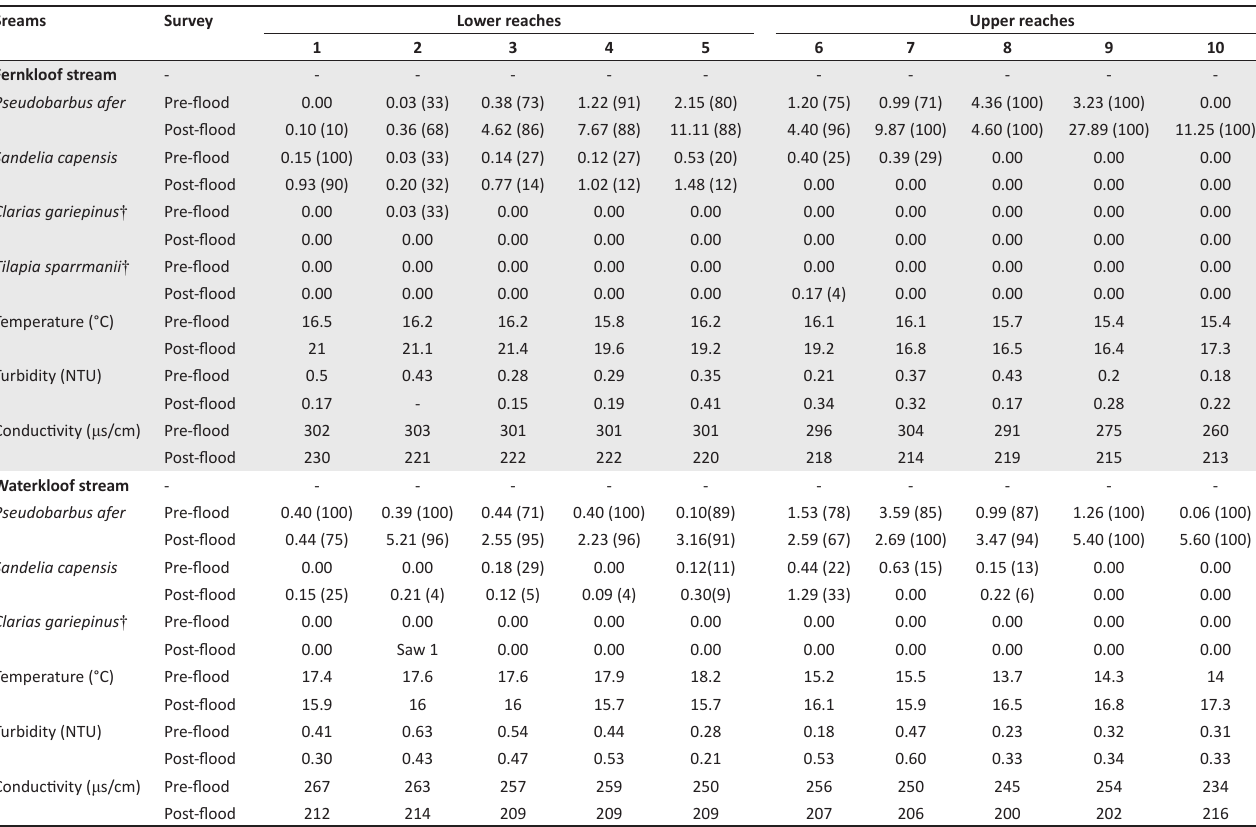
TABLE 1: The stream zones (lower reaches, upper reaches), sites (10 sites), distribution, catch per unit effort (fish m -3 ), relative abundance ( % ) of fishes by site ( % ), including water-quality variables from site 1 in the lower reaches to site 10 in the upper reaches of the Fernkloof and Waterkloof streams, headwater tributaries of the Kwa-Zunga River within the Groendal Wilderness Area. Sreams